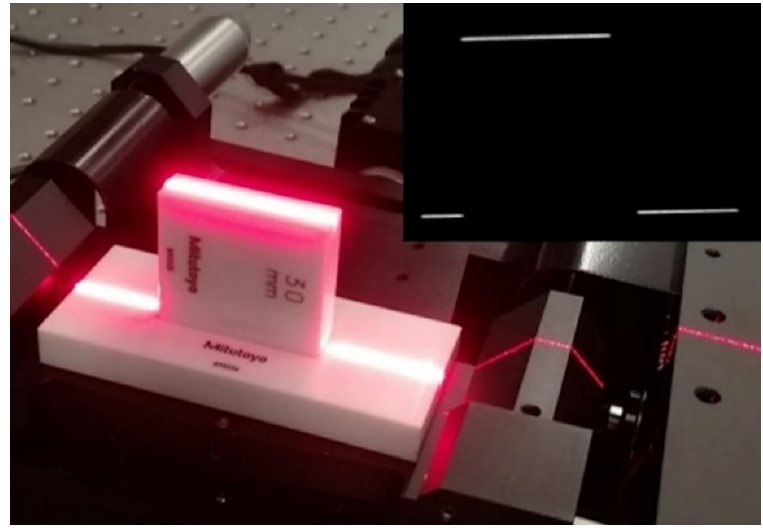
Figure 9. Gauge block measurement on Thorlabs stage to ensure alignment. Another block is placed to ensure a flat and reflective surface (such as the 30 mm block).